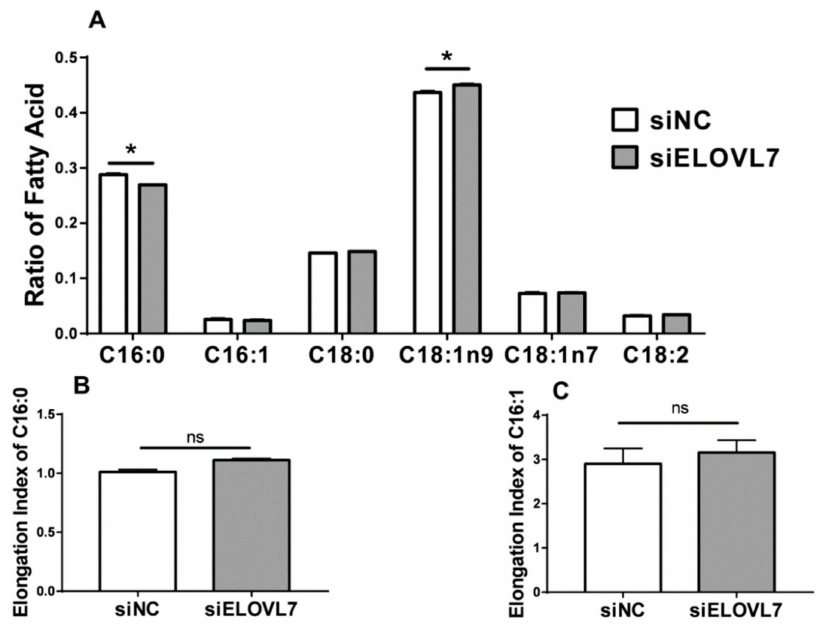
Figure 5. Knockdown of ELOVL7 altered the concentration of C16–C18 carbon fatty acids in GMEC. Goat mammary epithelial cells (GMEC) were incubated with siRNA target ELOVL7 (siELOVL7) or negative control (siNC) for 48 h and then collected for fatty analysis. Data are reported as ratio of total fatty acids. Values are means ± SEM from 3 individual cultures. The data were determined via Student’s t-test. * p < 0.05 compared with control (siNC). ns represents no significant change compared with control